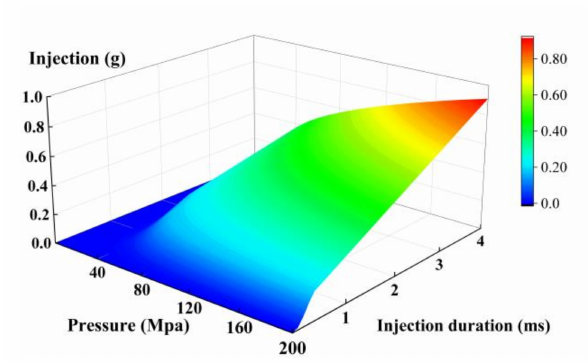
Figure 10. Characteristic data of injector